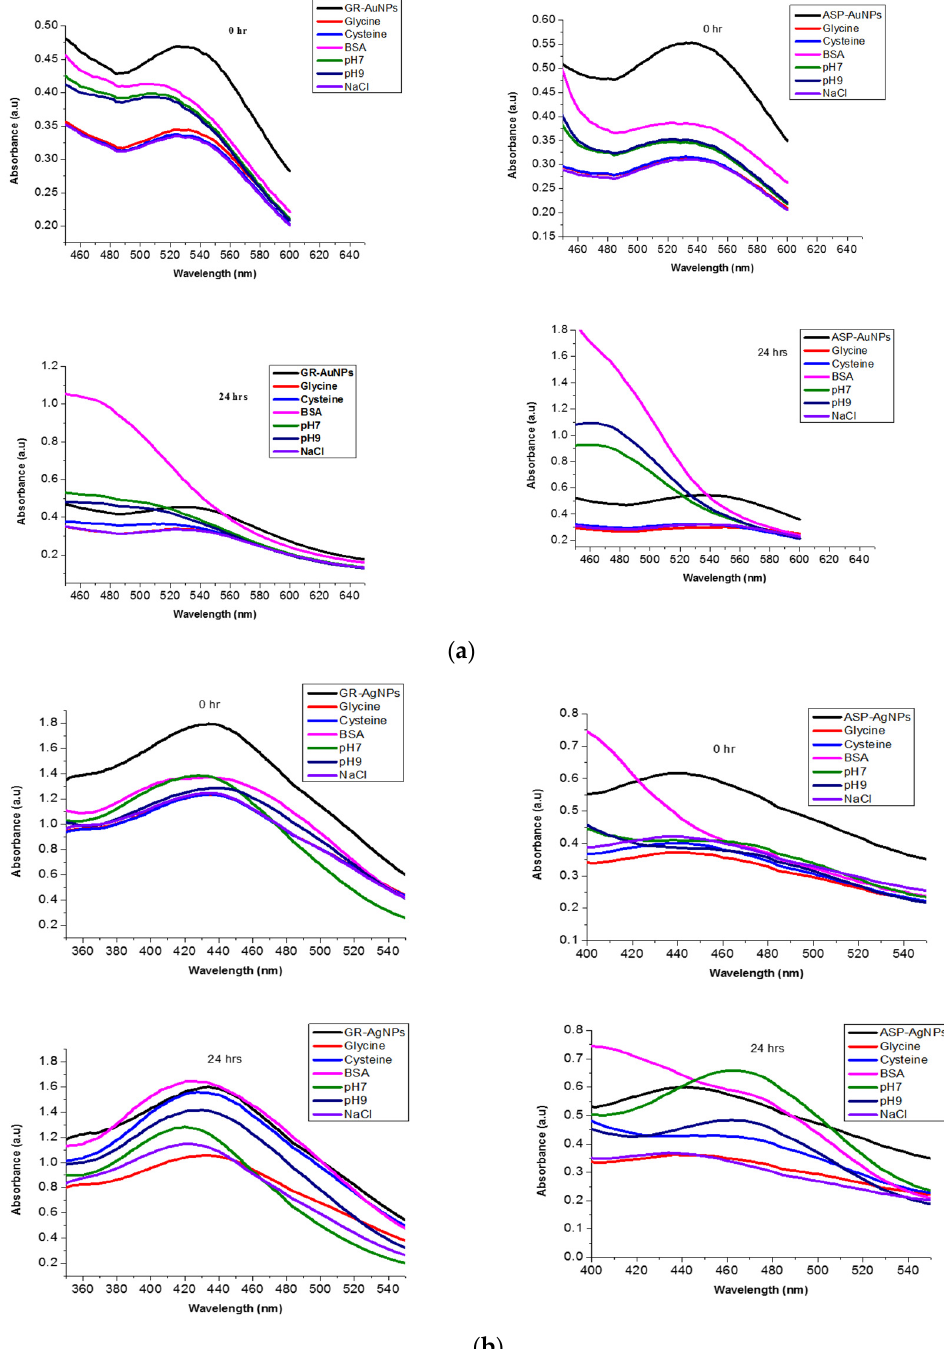
Figure 6. ( a ) In vitro stability of GR and ASP-AuNPs in biogenic media. ( b ) In vitro stability of GR and ASP-AgNPs in biogenic media .